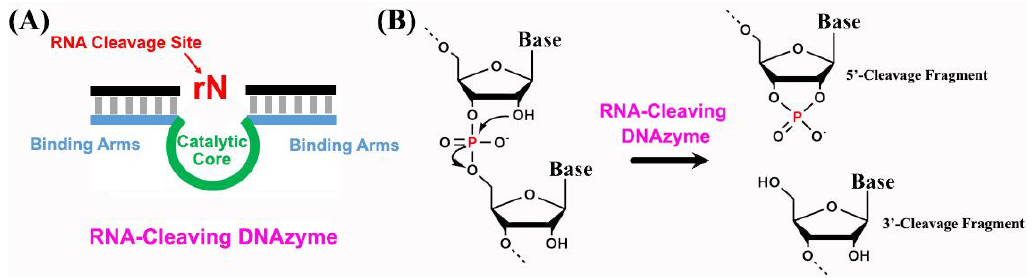
Figure 1. ( A ) A representative RNA-cleaving DNAzyme; ( B ) The common RNA cleavage reaction catalyzed by a RNA‐cleaving DNAzyme, resulting in two short nucleic acid fragments.